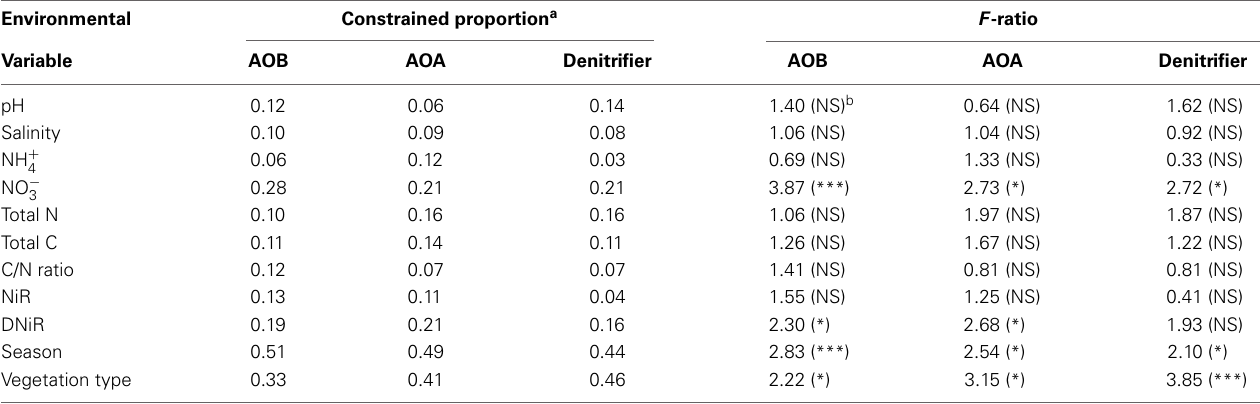
Table 3 | The conditional effects of environmental variables on the community compositional variation as determined by redundant analysis